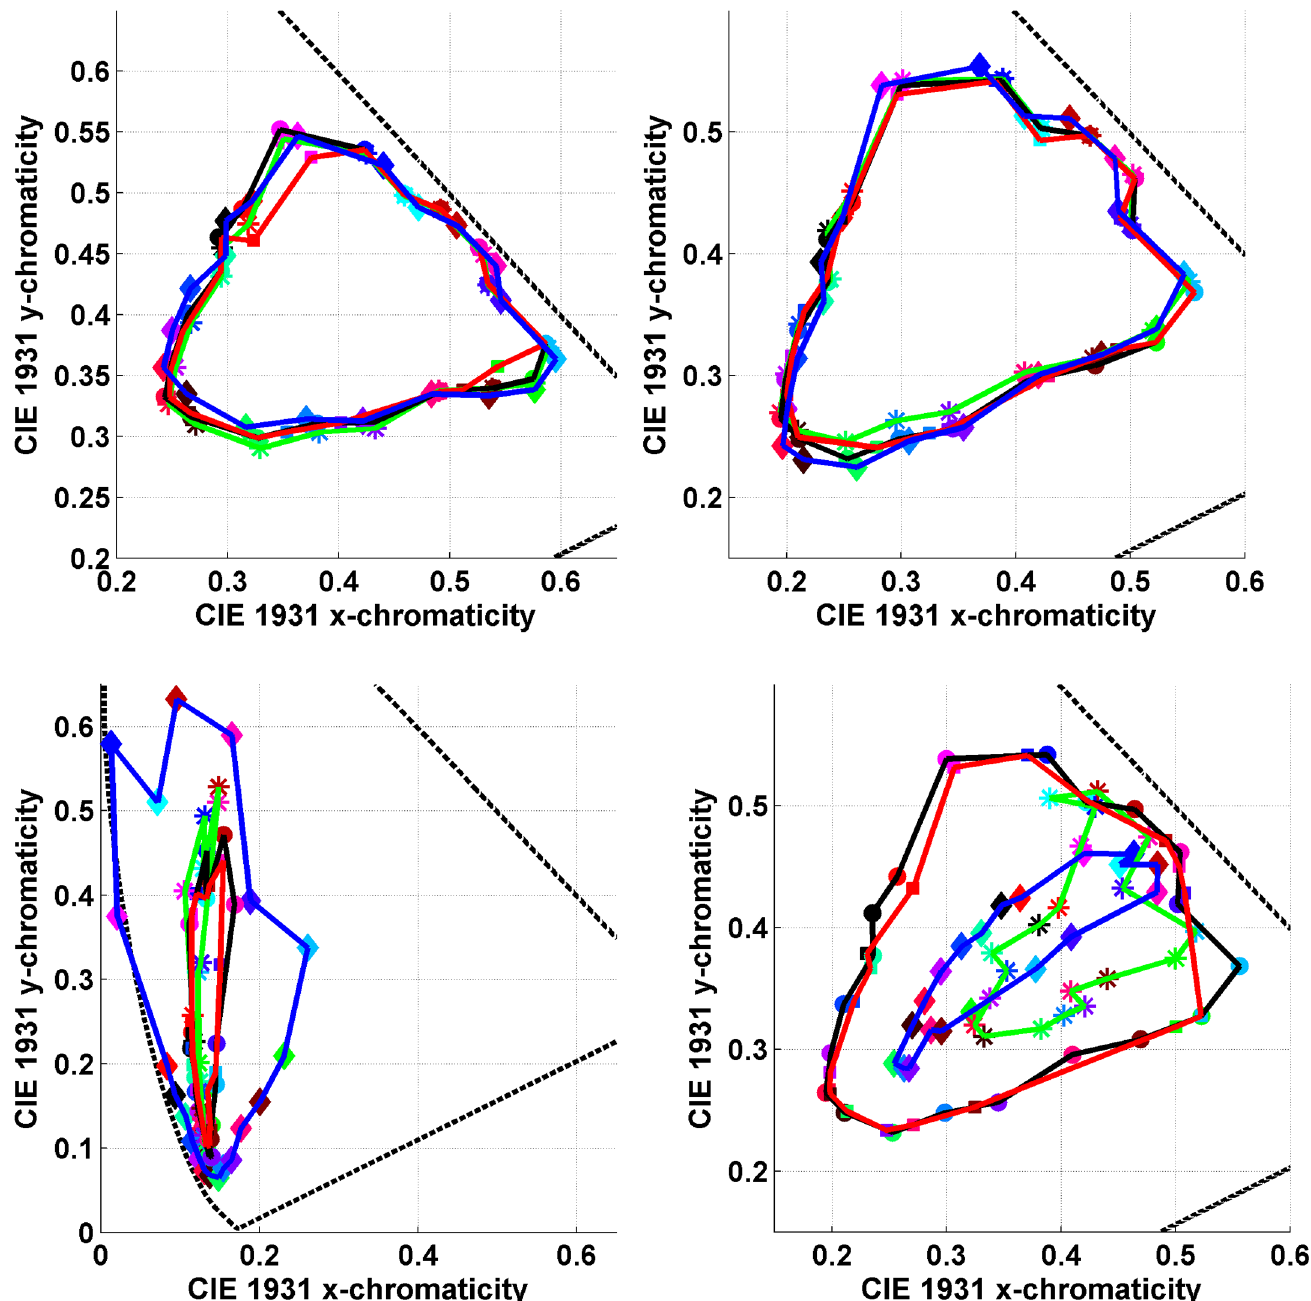
Fig 7. Comparison of asymmetric matches under 4 different illumination conditions (see Fig 8 for more). The asymmetric colour matches made by observers in Logvinenko & Tokunaga ’ s experiment are compared to predictions based on the mismatch centroid chromaticities, and on the von Kries transformation. The axes are those of the CIE 1931 xy-chromaticity diagram. Circular dots connected by the black lines stand for the stimulus papers. The squares connected by the red lines represent the averaged observer matches. Asterisks connected by the green lines stand for the mismatch centroid chromaticities. Diamonds connected by the blue lines indicate the prediction using the von Kries transformation. The dashed line is a segment of the spectrum locus. (a) Neutral/Yellow asymmetric colour matching condition. (b)Yellow/Neutral asymmetric colour matching condition. Note, however, that in (b) the squares connected by red lines indicate matches made under the neutral (N) illuminant, whereas in (a) the matches were under the yellow (Y) illuminant and so forth. (c) Blue/Neutral asymmetric colour matching condition. Note that one of the predictions using the von Kries transformation (blue curve) in fact falls outside the spectrum locus. (d) Neutral/Blue asymmetric colour matching